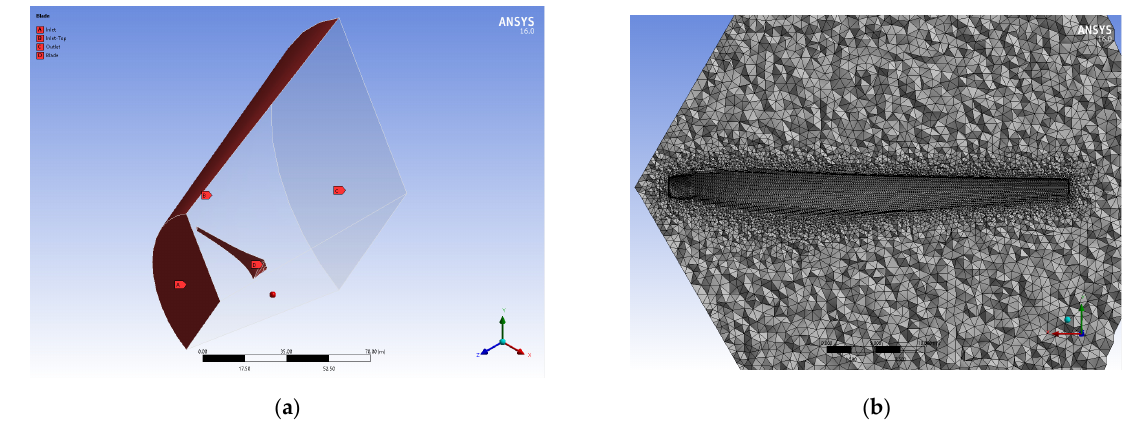
Figure 4. ( a ) Periodic computational domain and boundary conditions; ( b ) hybrid mesh close to the